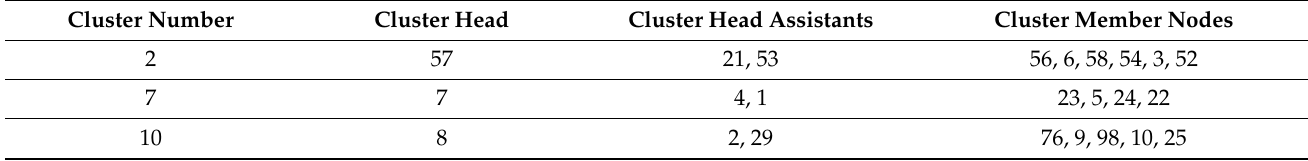
Table 3. Information on the 2nd, 7th, and 10th